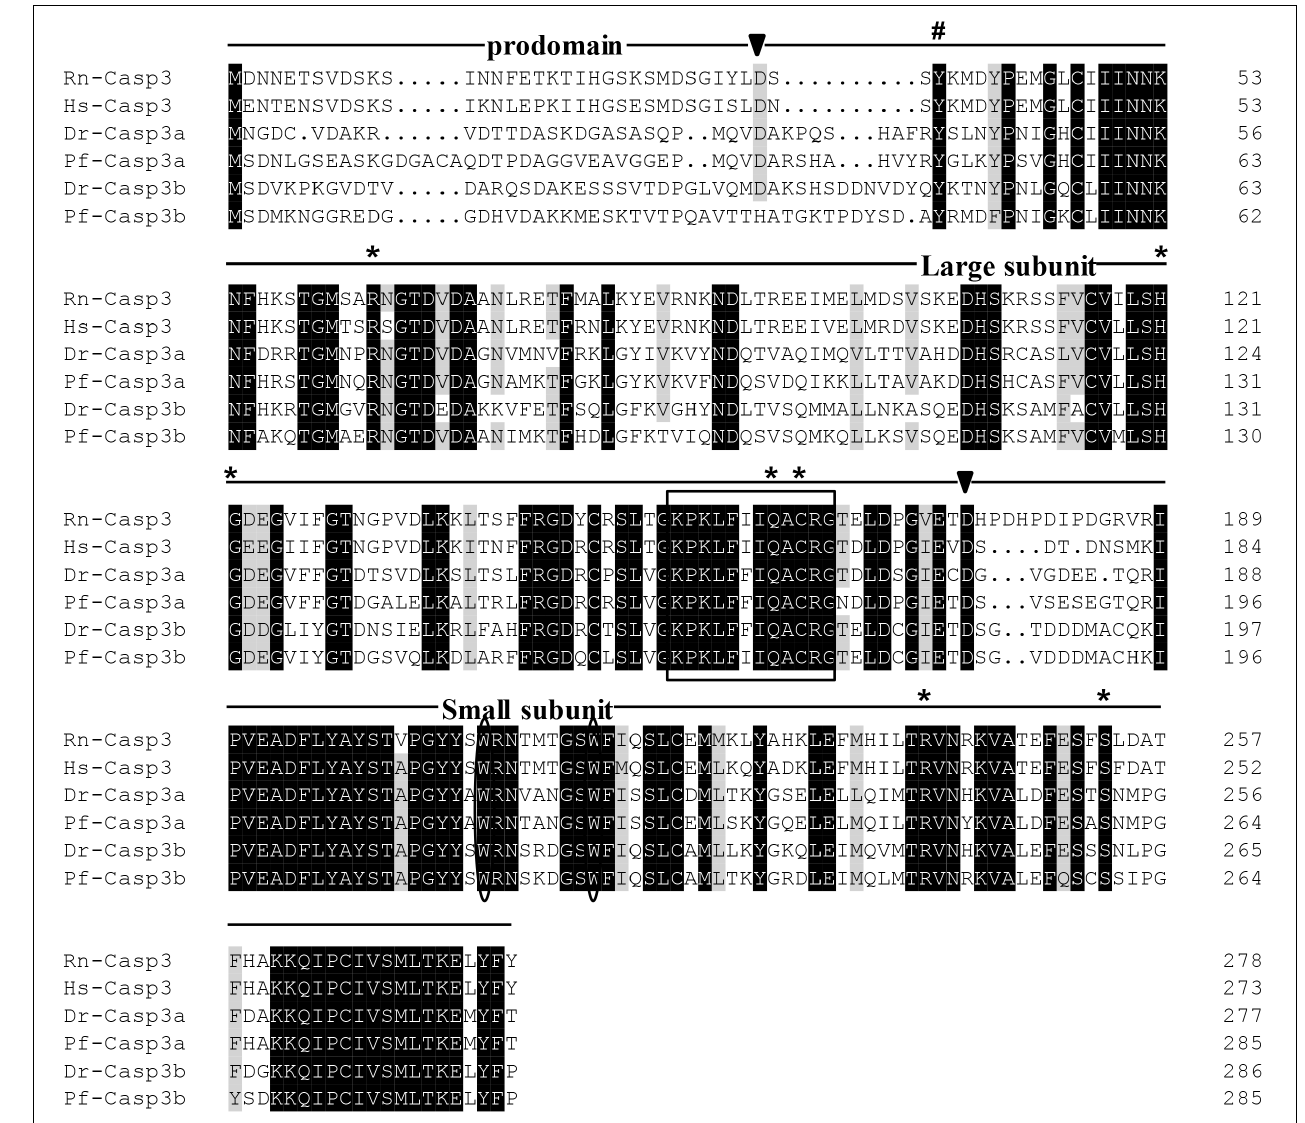
FIGURE 4 | Multiple amino acid sequence alignments of Casp3 genes from P. fulvidraco and other species. Deduced amino acid sequences were obtained from [ Rattus norvegicus (Rn), Homo sapiens (Hs), Danio rerio (Dr), and Pelteobagrus fulvidraco (Pf)] and Accession numbers are shown in order as